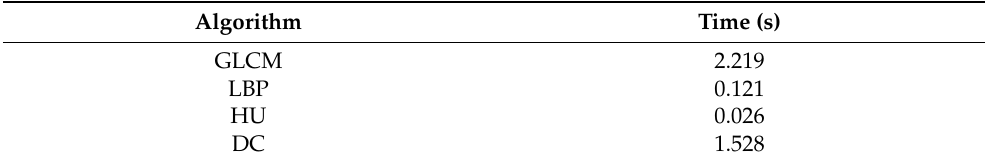
Table 3. Extraction times for each algorithm in seconds.